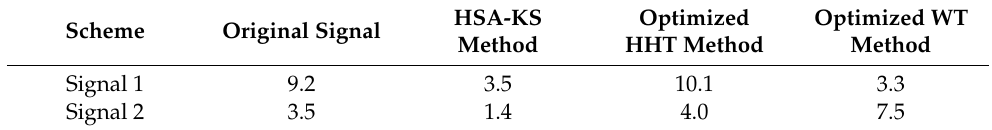
Table 1. D -values ( (cid:48)(cid:48) ) of typical jump signals before and after processing by the three schemes.